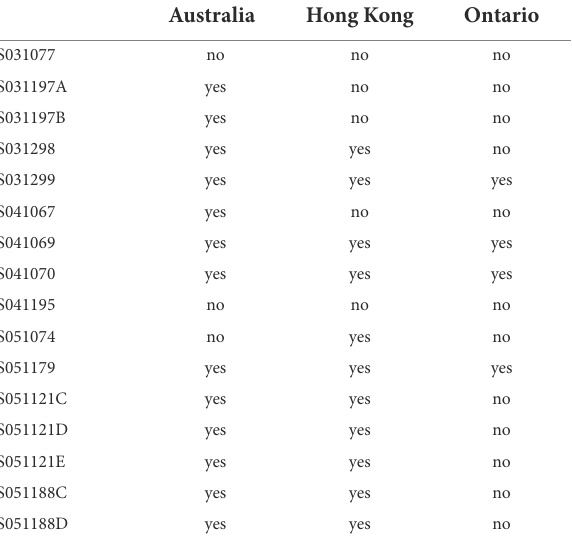
Table 4 Items covered in national curricula. Items Item covered in national curriculum